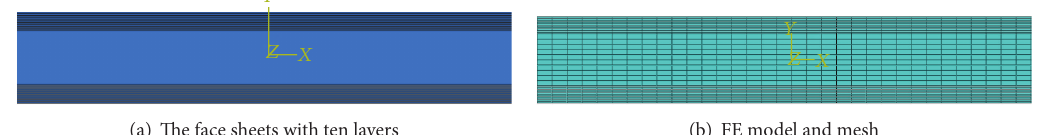
Figure 2: Model of the sandwich